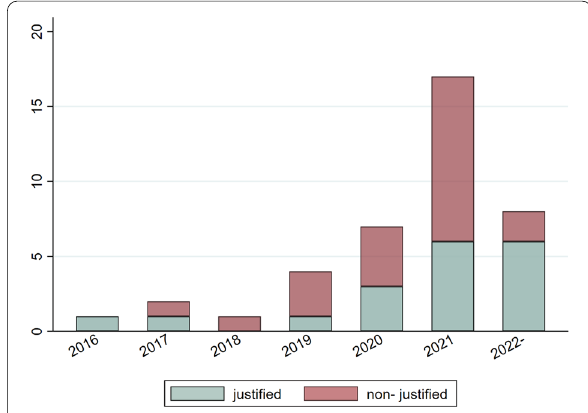
Fig. 2 Distribution of Scoping Reviews per justification practices, across the years